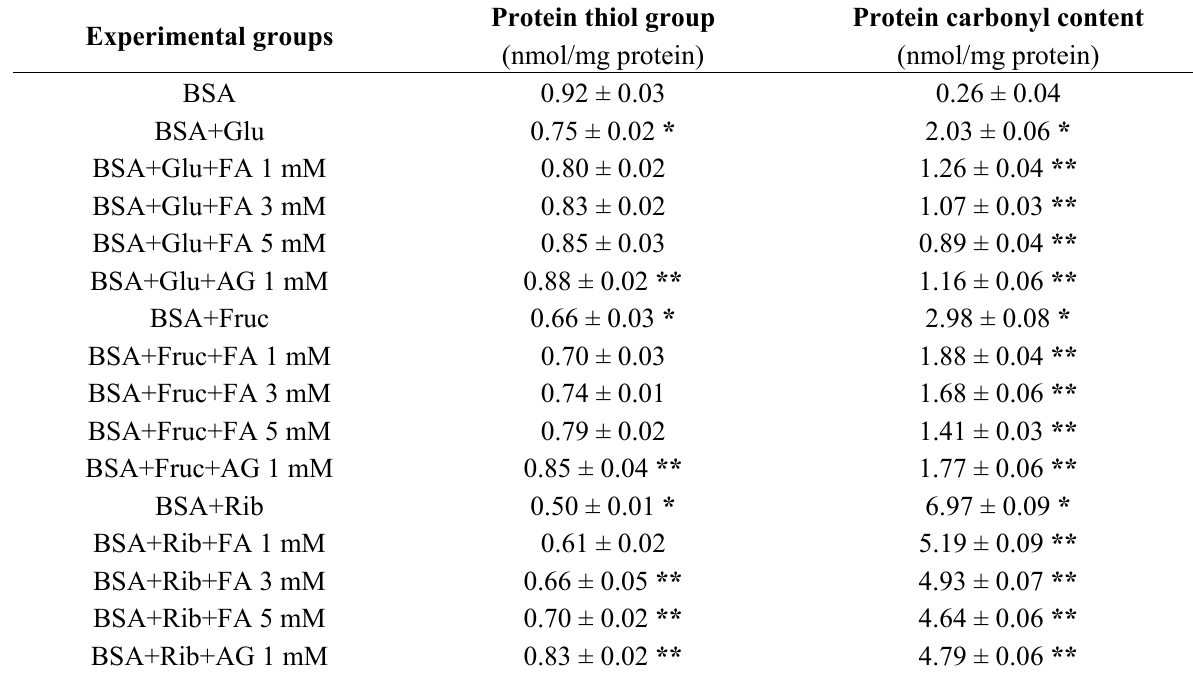
Table 1. Effect of FA on protein thiol group and protein carbonyl content in BSA incubated with glucose, fructose, and ribose at week 4. AG was used as positive control. The results are expressed as mean ± SEM ( n = 3). * p < 0.05 when compared to BSA, ** p < 0.05 when compared to BSA+Glucose, BSA+Fructose or